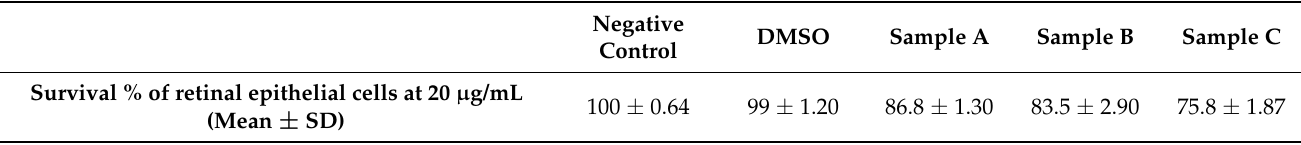
Table 2. Cytotoxicity and biocompatibility of AuQDs to the adult retinal cell line using MTT assay. Data are expressed as mean ± SD values of the three independent experiments.